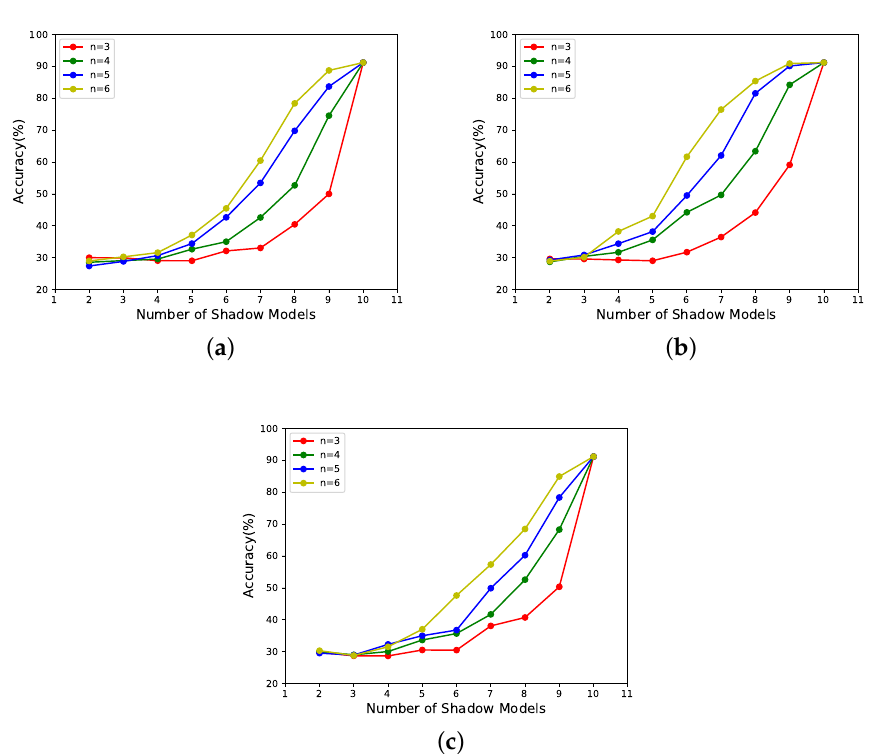
Figure 6. When k is constant, the relationship between x and the performance of reconstructed model for different determined sharing states. ( a ) All candidate shadow models’ weights and shadow models’ weights are 1. ( b ) 3 of candidate shadow models’ weights are 10, and the rest are 1. 3 of shadow models’ weights are 10, and the rest are 1. ( c ) 3 of candidate shadow models’ weights are 1, and the rest are 10. 3 of shadow models’ weights are 1, and the rest are